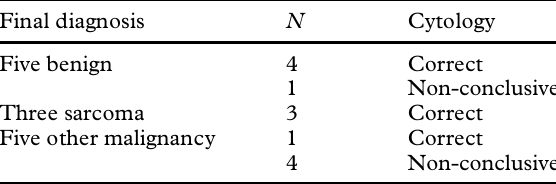
Table 2. Original review: the 13 homogenous cases